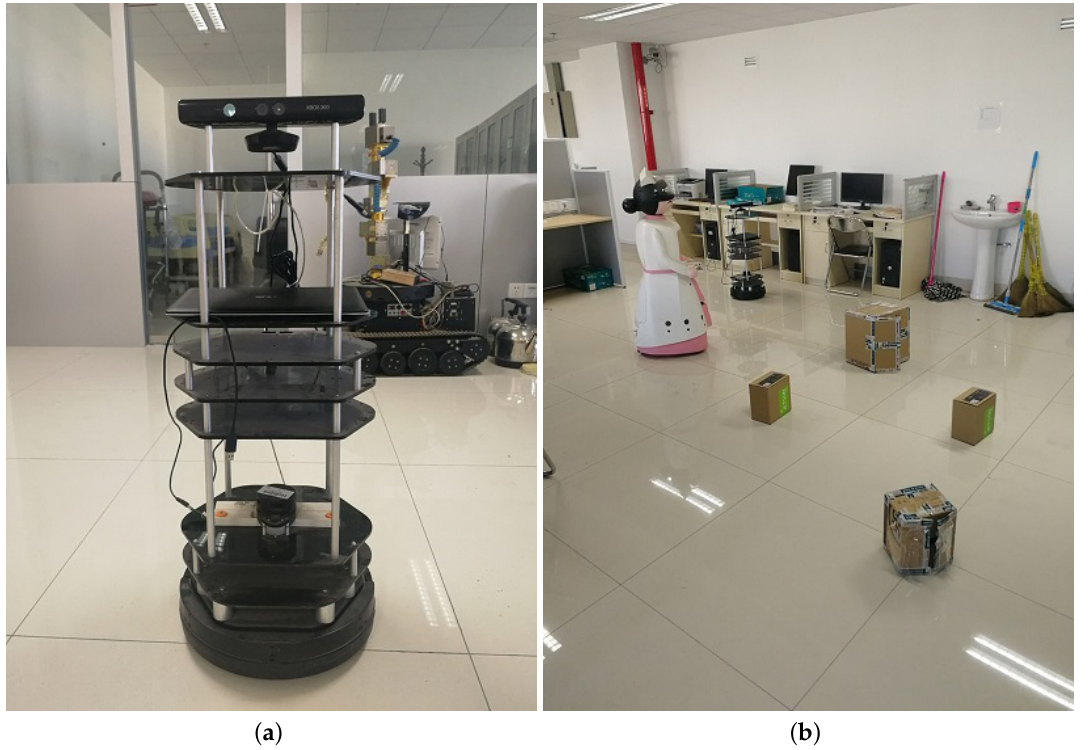
Figure 5. ( a ) Turtlebot robot and ( b ) experimental environment.